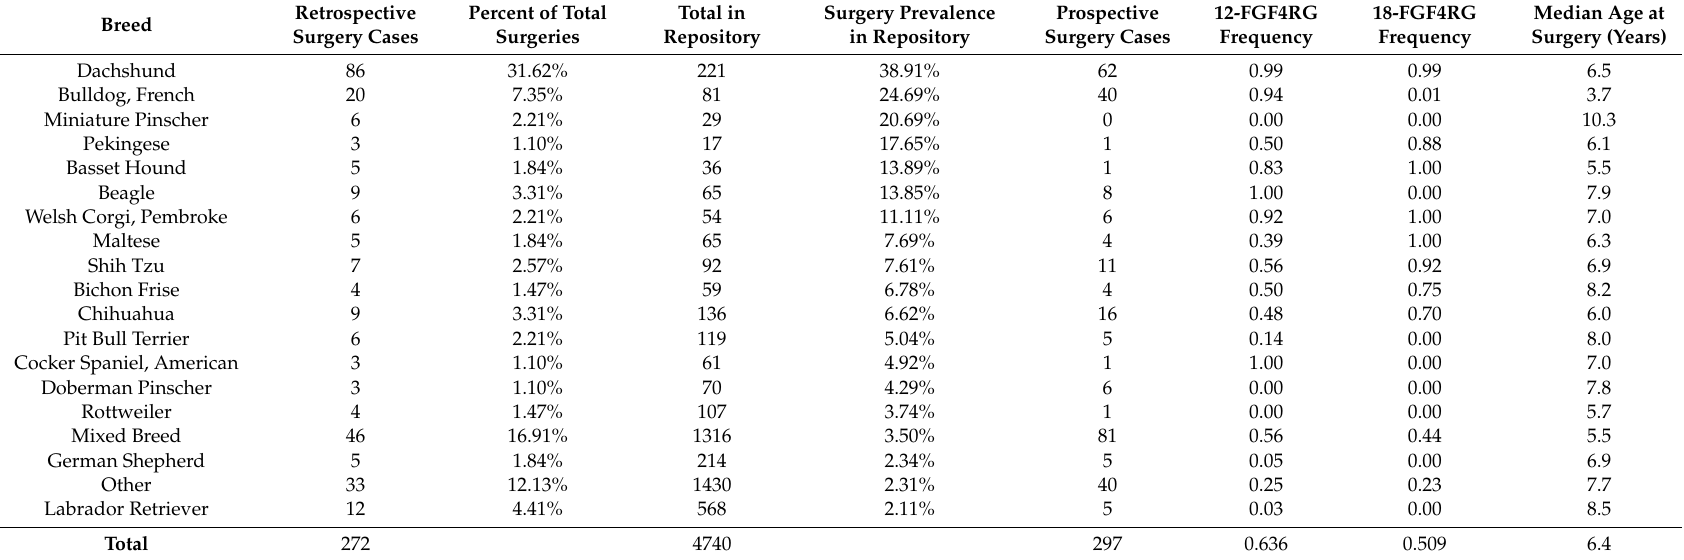
Table 1. Descriptive statistics for dogs surgically treated for intervertebral disc disease (IVDD). Any breed with fewer than three retrospective surgery cases was included in ’Other’. Dogs from 61 di ff erent breeds and 127 mixed breed dogs were defined. The total number of dogs from each breed in the DNA repository is included, and the list is sorted by the breed prevalence of surgical